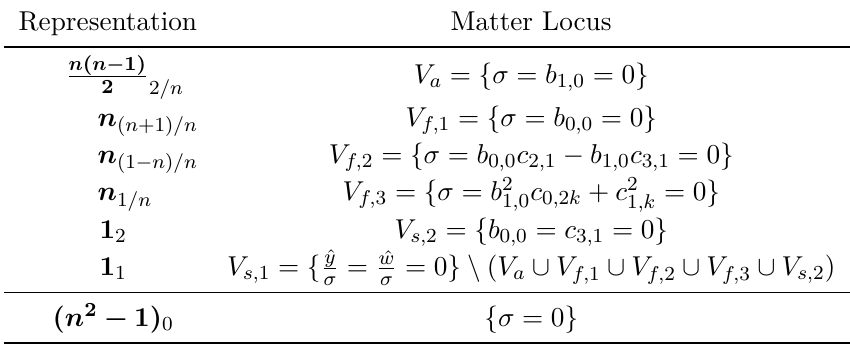
Table 8. Matter spectrum for the su ( n ) ⊕ u (1) fundamental seed models for n = 2 k + 1 and k ≥ 1 . Note that one can flip the sign of all u (1) charges and obtain an equally valid description of the matter spectrum (with a different value of ν ). For n = 3 ( k = 1 ), the matter spectrum is similar